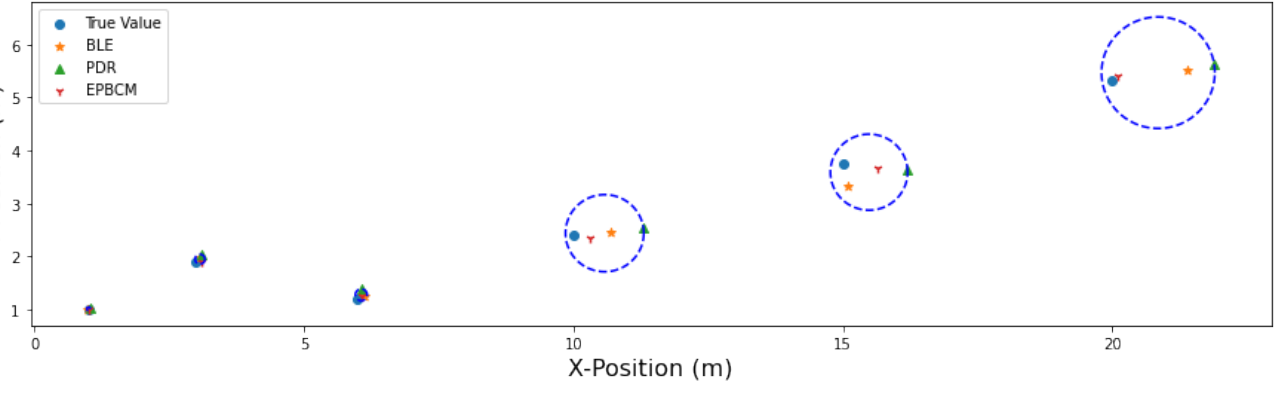
Figure 10. Mobile position estimation using BLE-beacon, PDR, and the EPBCM